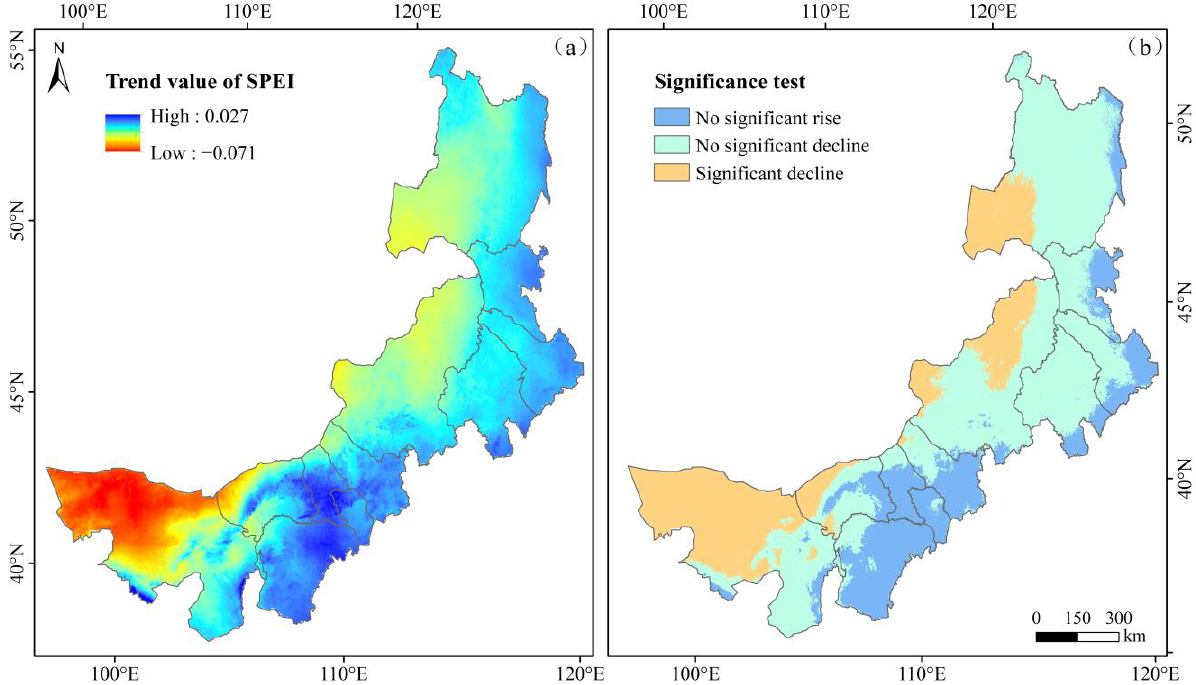
Figure 11. Change trends and significance tests of SPEI in space in Inner Mongolia. ( a ) shows the 38-year SPEI change trend values in Inner Mongolia calculated by the Theil–Sen median trend analysis. Values greater than 0 represent wetting, and values less than 0 represent aridity. ( b ) are the results from the superposition of the Theil–Sen trend analysis and the Mann–Kendall test, showing the significance of drought change